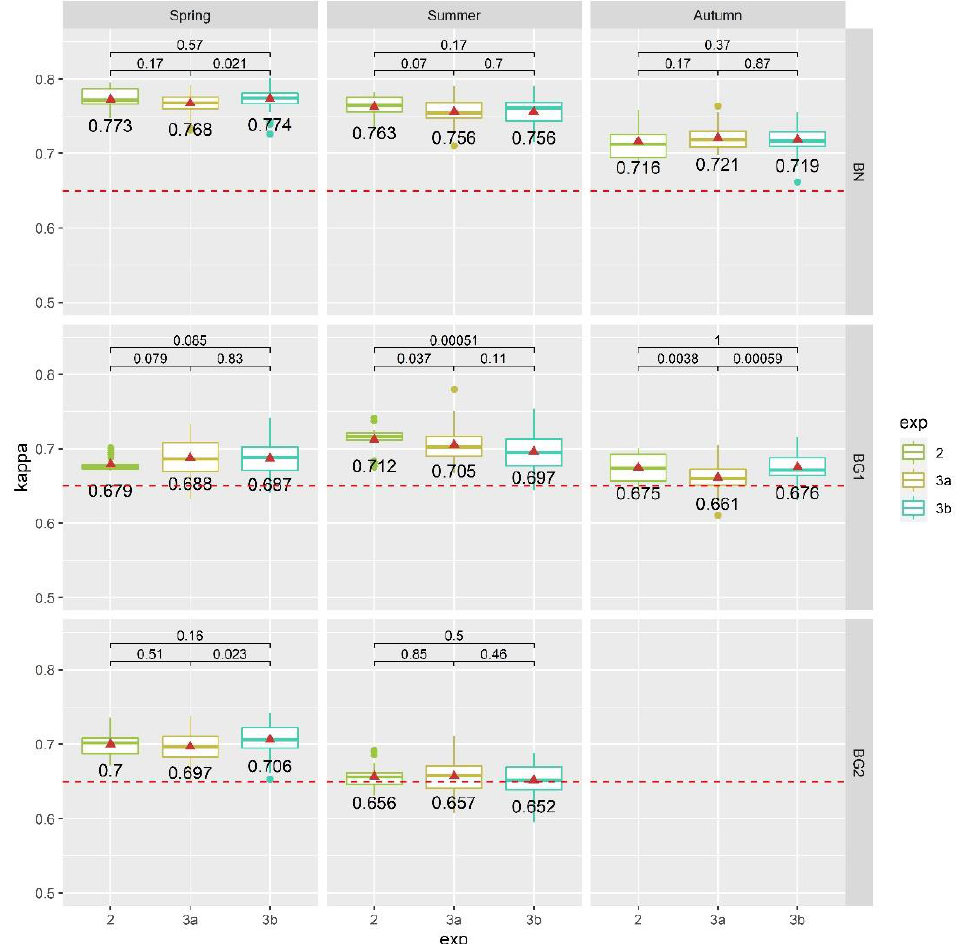
Figure 11. Comparison of K accuracies obtained in Exp. 2, Exp. 3a, and Exp. 3b. p-values resulting from the Wilcoxon test comparisons are displayed. Red triangles represent the mean K values (also written). Boxplots show the median, the lower, and upper hinges corresponding to the first and third quartiles; the upper and the lower whiskers are the 1.5 · interquartile range. Red dotted lines represent a confidence level of K = 0.65.